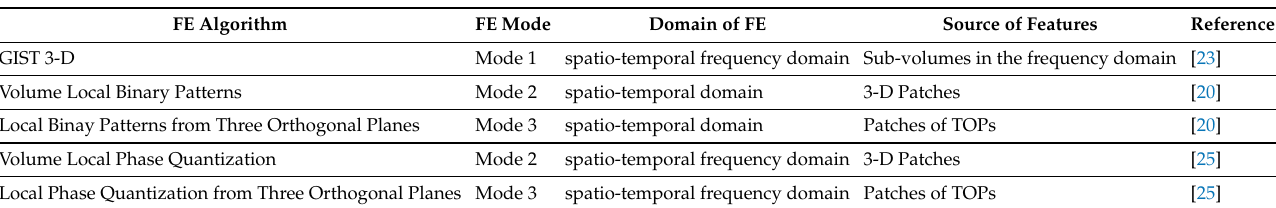
Table 2. The used feature extraction (FE)